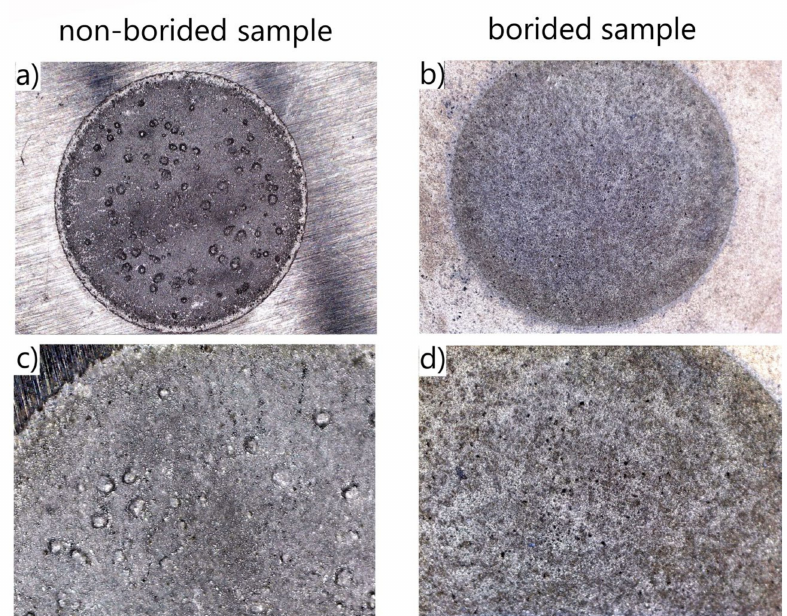
Figure 10. Macroscopic images of the corroded surface of non-borided ( a , c ) and borided ( b , d ) Inconel ® 600 alloy after the corrosion resistance test in a 3.5% NaCl solution.